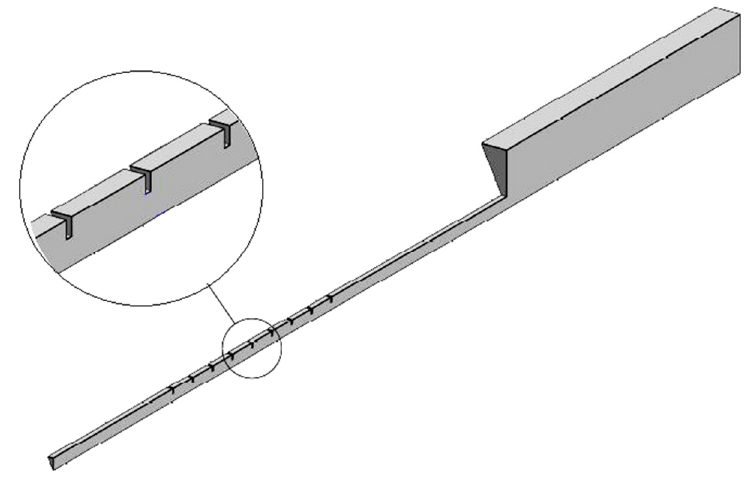
Figure 2. The schematic of the wedge-type computational domain.